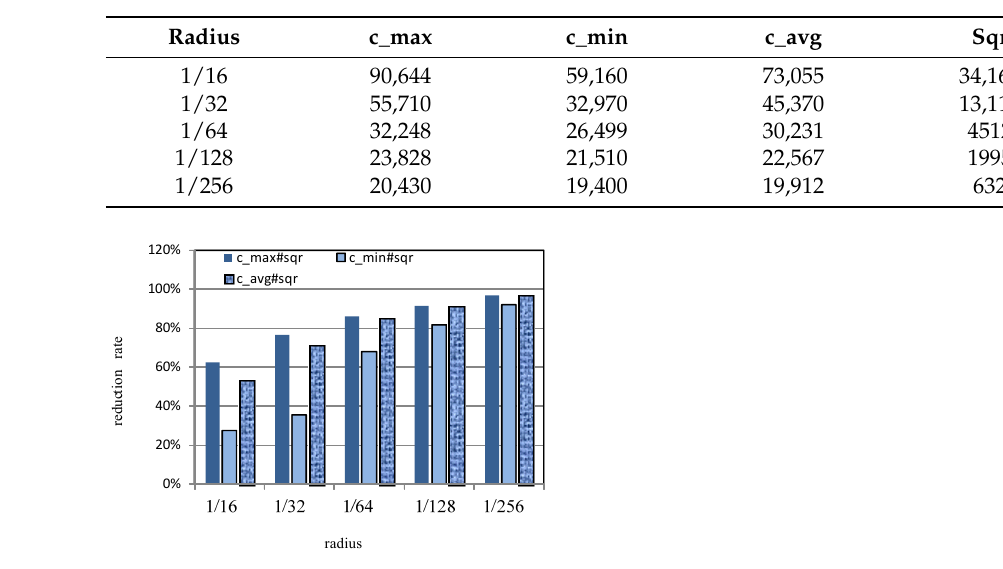
Table 6. The numbers of outer points.